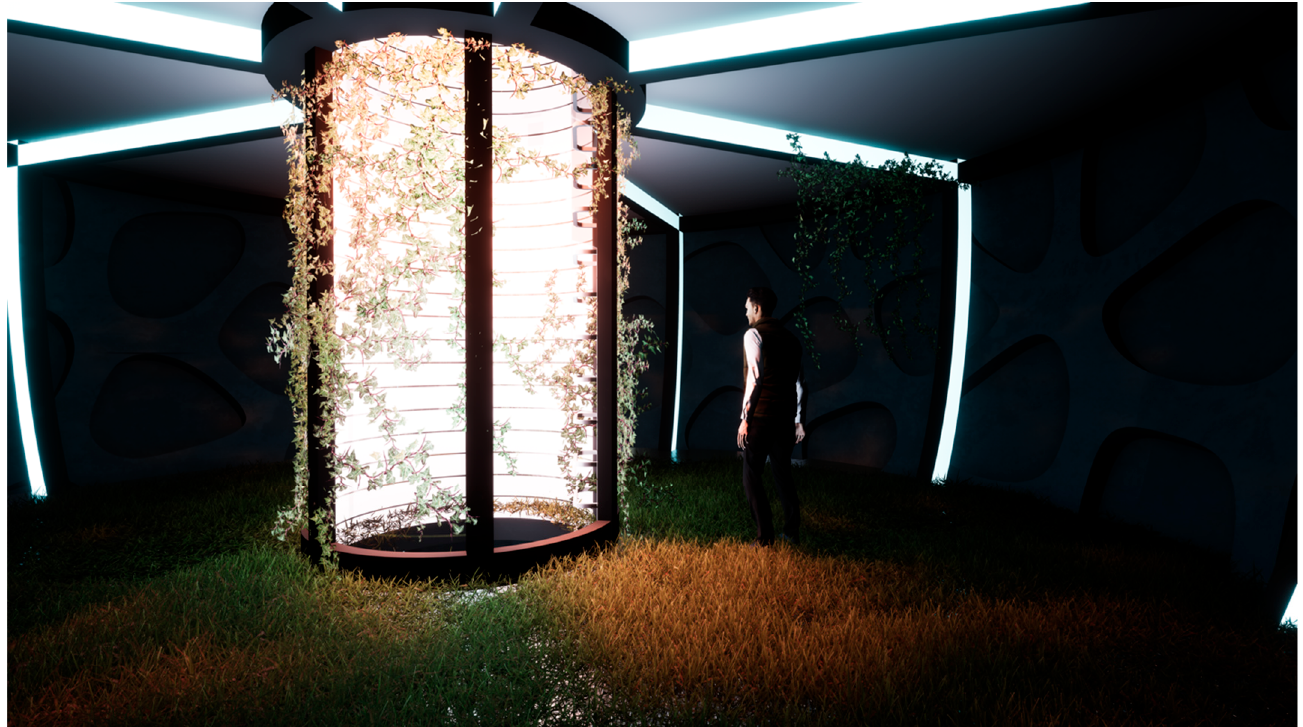
Figure 11. Perspective view of the first floor (command floor) of the habitat. A light tube can be seen in the image.